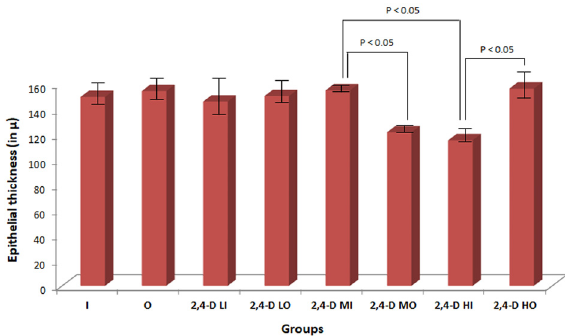
Figure 3. Thickness of the stratum corneum (in m ) in the experimental groups (n=79). Data are reported as mean ± SD (ANOVA). I: Inhalation control group; O: Oral control group; 2,4-D LI: Group exposed to low concentration of 2,4-dichlorophenoxy- acetic acid (2,4-D) by inhalation; 2,4-D LO: Group exposed to low concentration of 2,4-D orally; 2,4-D MI: Group exposed to moderate concentration of 2,4-D by inhalation; 2,4-D MO: Group exposed to moderate concentration of 2,4-D orally; 2,4-D HI: Group exposed to high concentration of 2,4-D by inhalation; 2,4-D HO: Group exposed to a high concentration of 2,4-D orally.